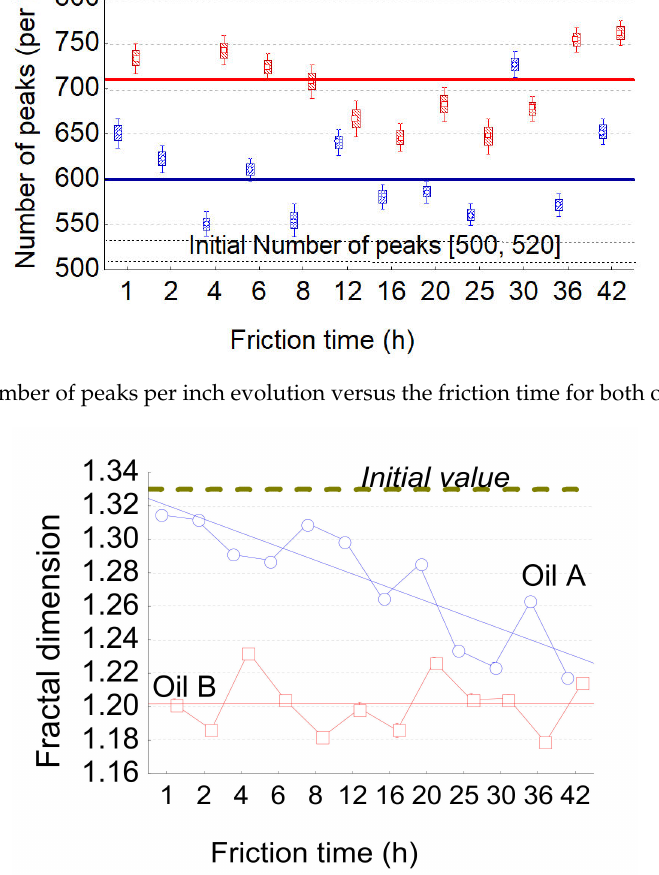
Figure 18. Fractal dimension evolution versus the friction time for both oils (A and